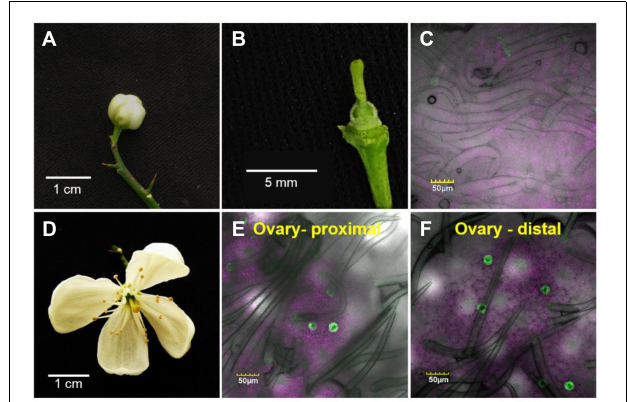
FIGURE 3 | Distribution of stomata on the organs of an open citrus flower. The confocal images B , C , and D are merged images of white light, chlorophyll autofluorescence (stained magenta), and GFP fluorescence (stained green). Flowers were harvested from GCGFP plants. (A) An open GCGFP flower. (B) Confocal image of a style removed from an open flower, as indicated in panel A . (C) Confocal image of a sepal removed from an open flower, as indicated in panel A . (D) Confocal image of a petal removed from an open flower, as indicated in panel A . Analyses were performed on five biological